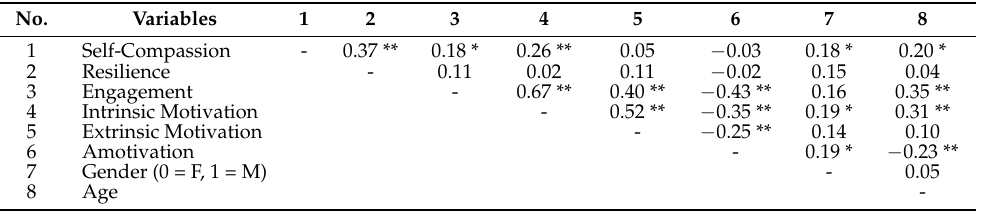
Table 2. Correlations among self-compassion, resilience, engagement and motivation in Irish social work students ( n =